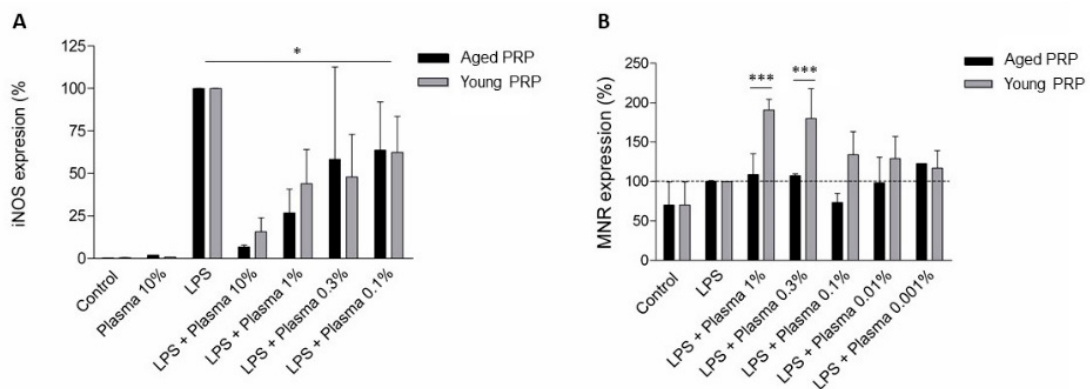
Figure 8. Expression of enzyme-inducible nitric oxide synthase (iNOS), a pro-inflammatory marker indicative of the M1 inflammatory phenotype ( A ) and mannose receptor (MNR), an anti-inflammatory marker indicative of the M2 restorative phenotype ( B ) in microglia of rats treated with different plasma concentrations. * p < 0.05; *** p < 0.001. Error bars = standard deviation.